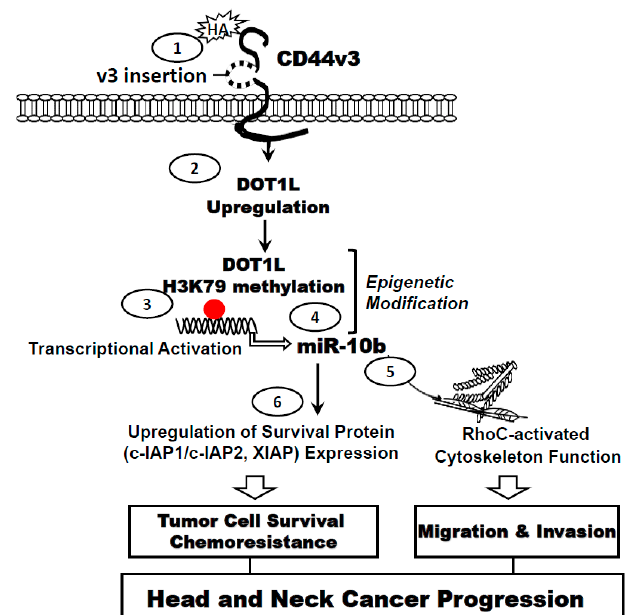
Figure 4. A summary for DOT1L-H3K79 methylation signaling in influencing miRNA-10 gene expression and production as well as Cancer Stem Cell (CSC) functions in HA-treated CD44v3 high ALDH1 high cells. The binding of HA ( Step 1 ) to CD44v3-expressing CSCs enhances DOT1L upregulation ( Step 2 ) and DOT1L/H3K79 methylation-mediated epigenetic changes ( Step 2 ), resulting in methyl-H3K79 binding to miR-10b promoter ( Step 3 ), and miR-10b gene expression/production ( Step 4 ). The expressed miR-10b then promotes upregulation of RhoC (cytoskeleton activator) and CSC-mediated invasion ( Step 5 ). Moreover, miR-10b also induces survival protein, IAP (cIAP-1/cIAP-2 and XIAP) expression, HNSCC cell anti-apoptosis/survival and chemoresistance ( Step 6 ). Red dot represents DOT1L/H3K79-mediated histone modifications (via epigenetic changes). Taken together, these findings suggest that targeting HA-mediated DOT1L/H3K79 methylation pathways and miR-10b function may provide a new drug target to sensitize cancer stem cell apoptosis/death and overcome cisplatin resistance in CSC-derived HNSCC cells.